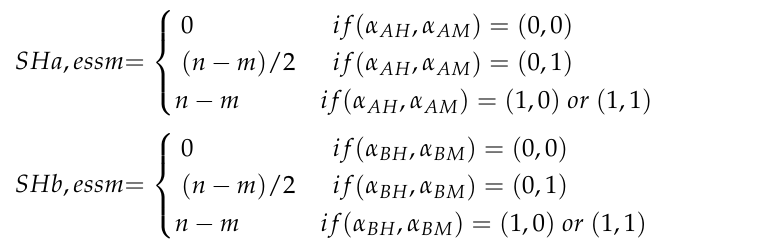
Table 1. Left-shift for the ESSM multiplier.